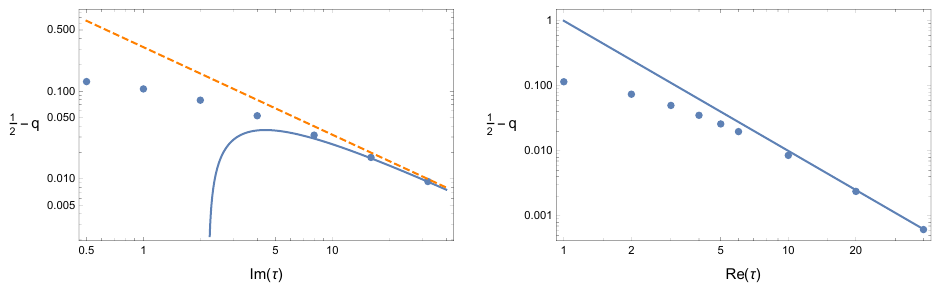
(cid:0) q while 2